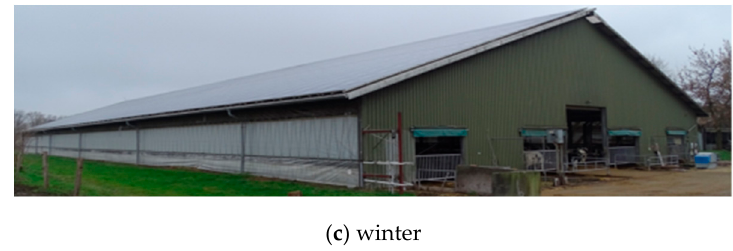
Figure 1. Sidewall opening practices of the naturally ventilated dairy (NVD) barn in Dummerstorf, Germany in different seasons, ( a ) in summer, ( b ) in early spring and autumn, and ( c ) in winter.